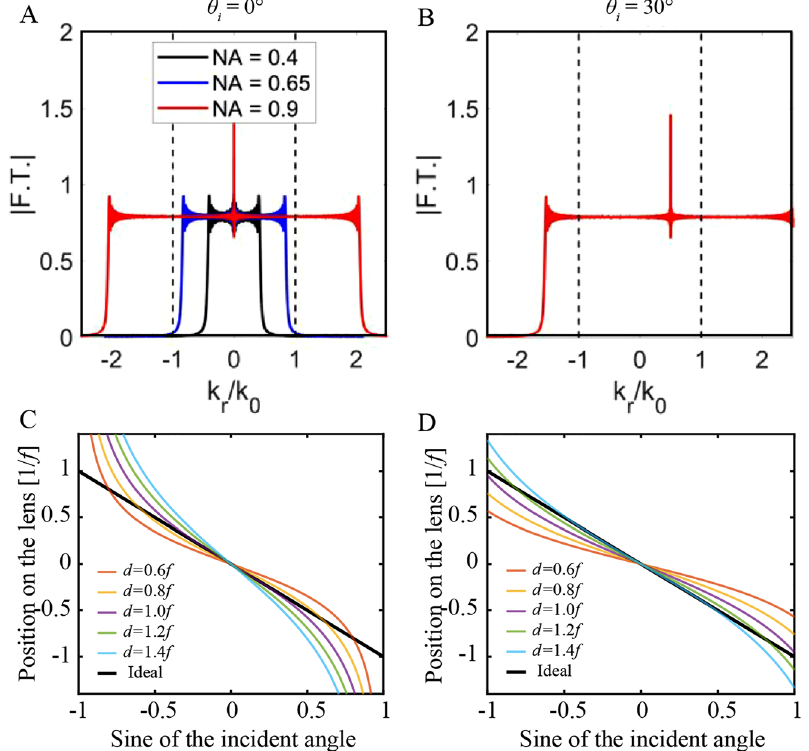
Figure 3: Performance of quadratic metalenses. (A) Fourier transform spectra of the wide-angle metalens for an NA of 0.4 (black), 0.65 (blue), and 0.9 (red), for normal incidence. (B) Same as the red line in (A), but for oblique incidence. Adapted with permission from ref. [85]. Copyright 2020, American Chemical Society. (C – D) Position of the light axis projected onto two kinds of landscape quadratic metalenses after passing through the aperture stop for the con fi guration of Figure 2C and E, assuming that the refractive index of the dielectric gap is equal to